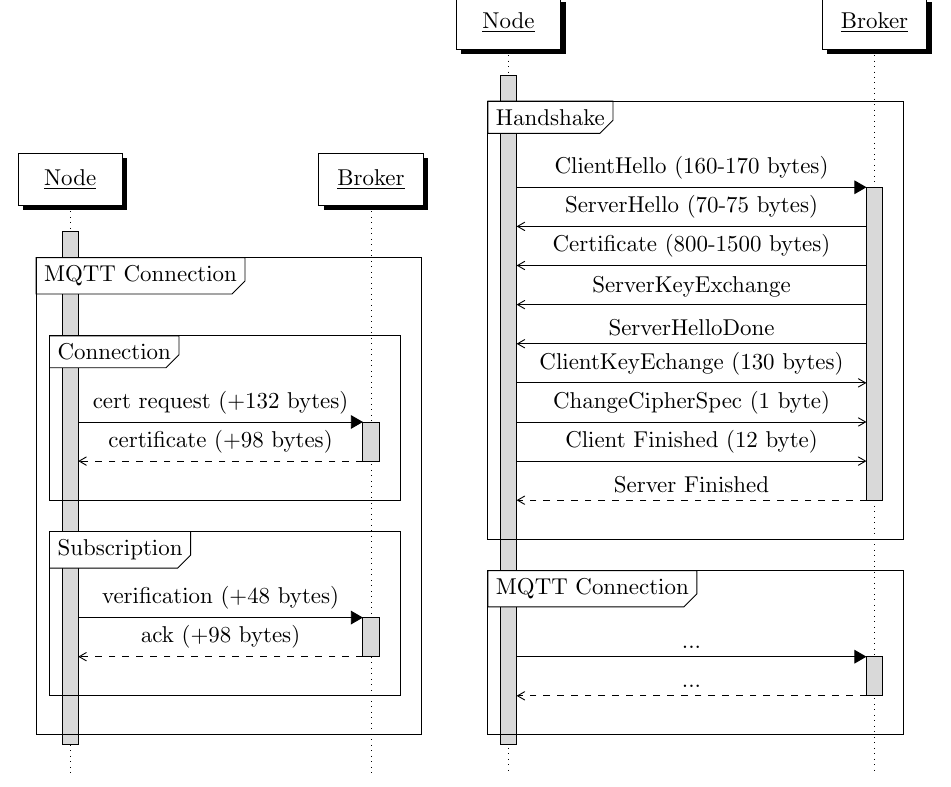
Figure 6. Comparison of the size overhead of our security scheme compared to a TLS 1.2 handshake. Details on TLS packets are shown in Table